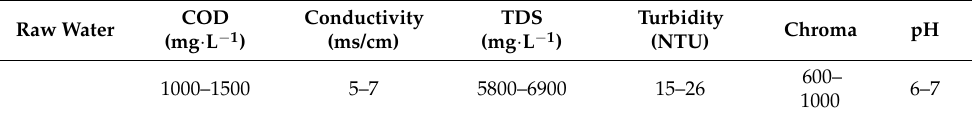
Table 3. Characteristics of the raw